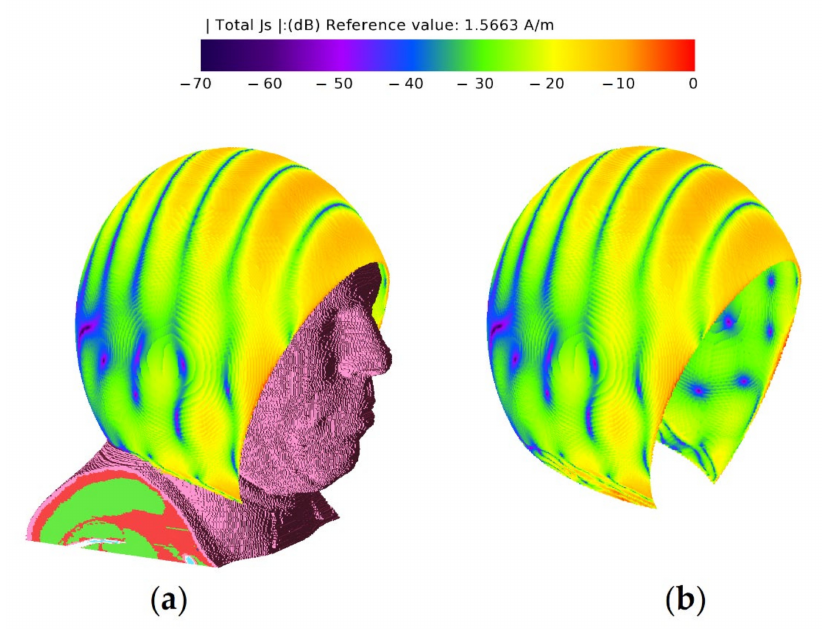
Figure 19. Current distribution in the shield structure for 3600 MHz with the head ( a ) visible and ( b ) not